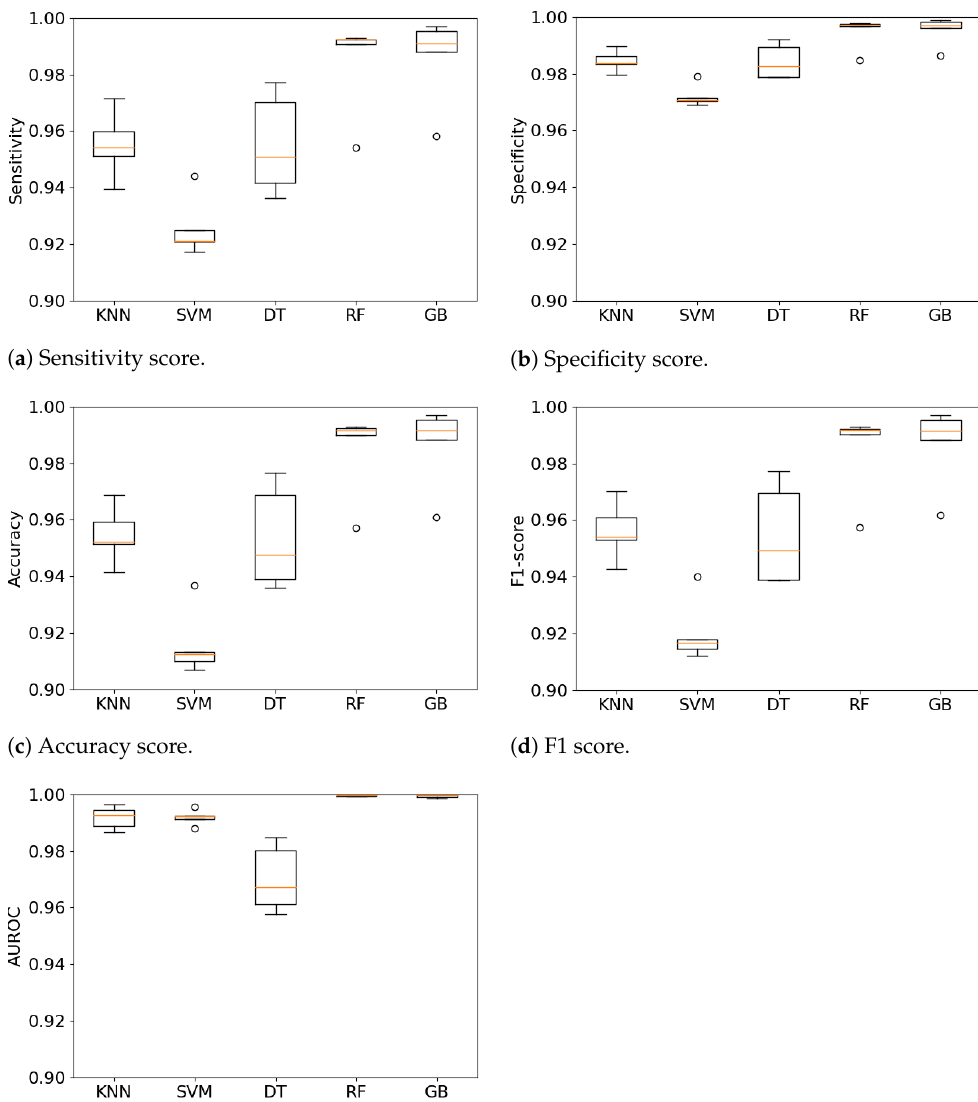
Figure 5. Comparison of various metrics including Sensitivity, Specificity, accuracy, F1 and AUROC of each k-fold split across the ML